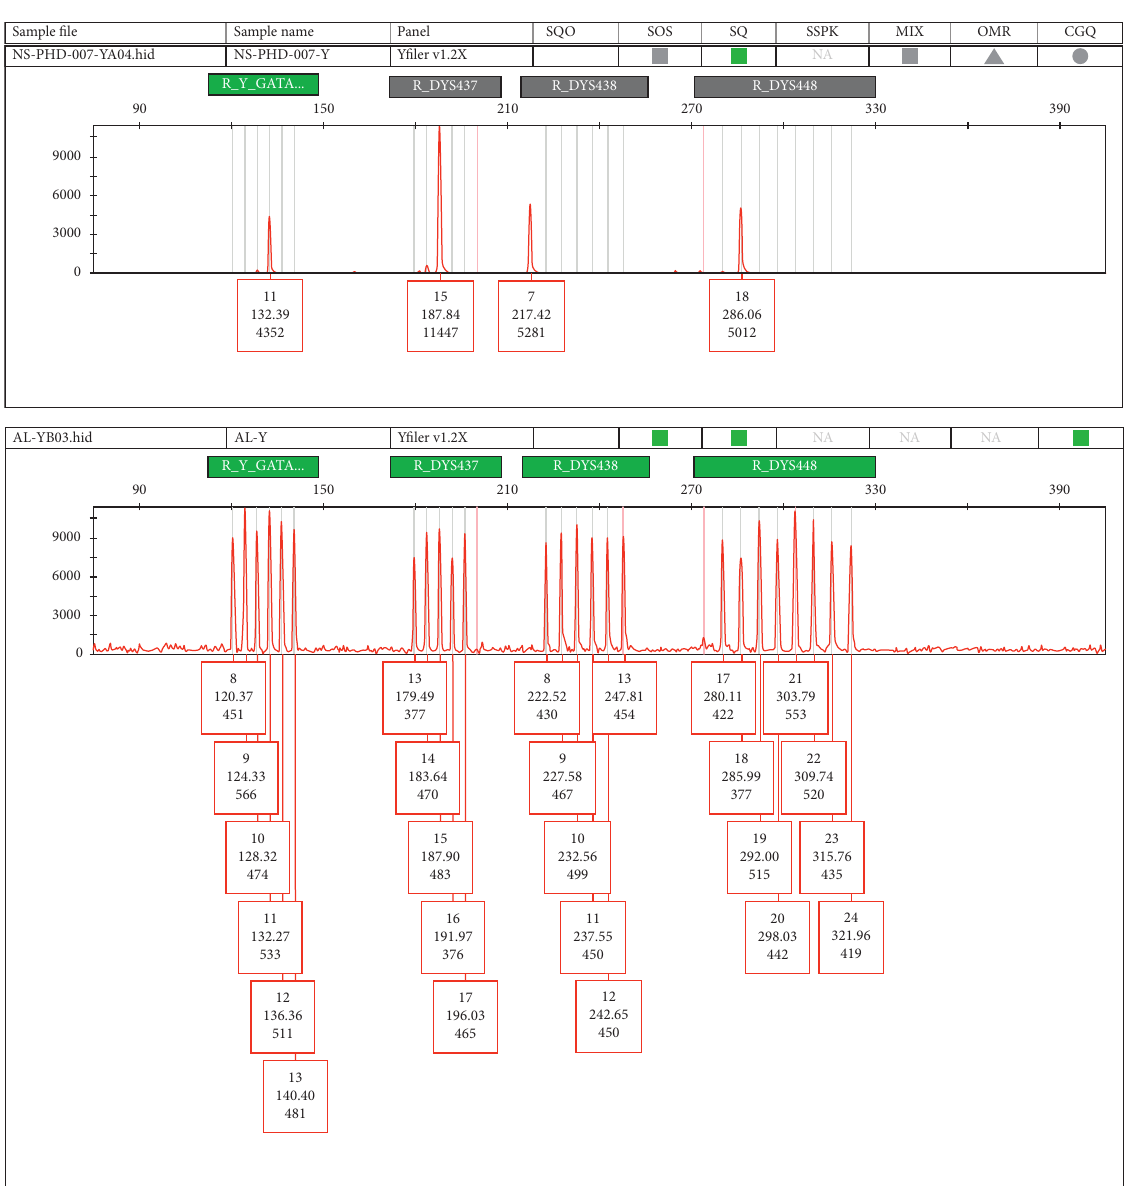
Figure 2: A profile of AMEL-Y-null male with off-ladder allele variant 7 at